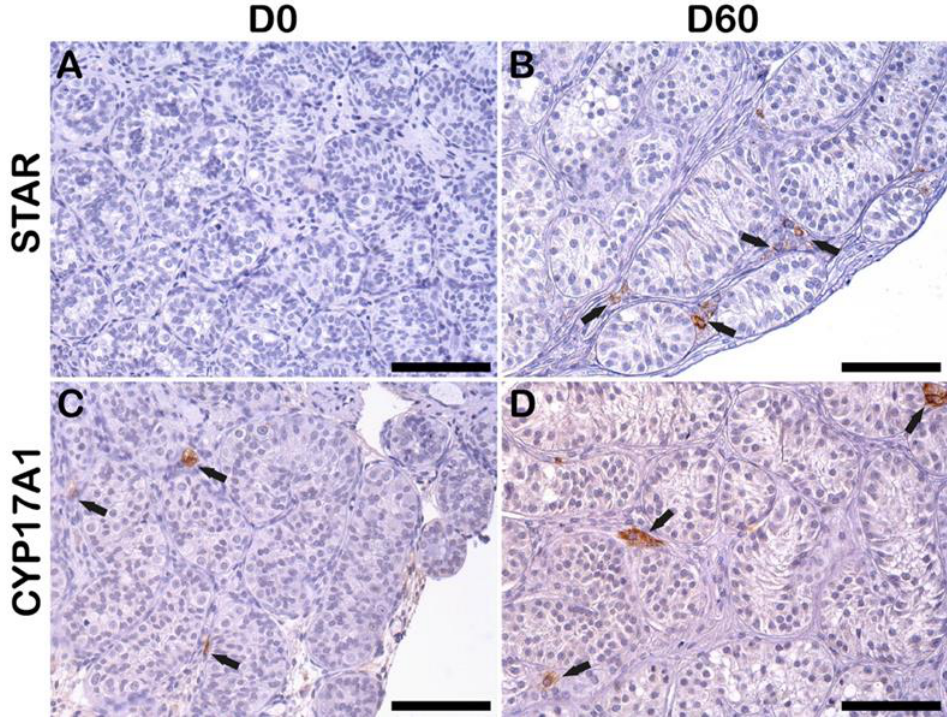
Figure 6. Leydig cell functionality. IHC staining of Leydig cells for STAR at D0 ( A ) and D60 ( B ), CYP17A1 at D0 ( C ), and D60 ( D ). Scale bar = 100 µ m. The black arrow indicated positive